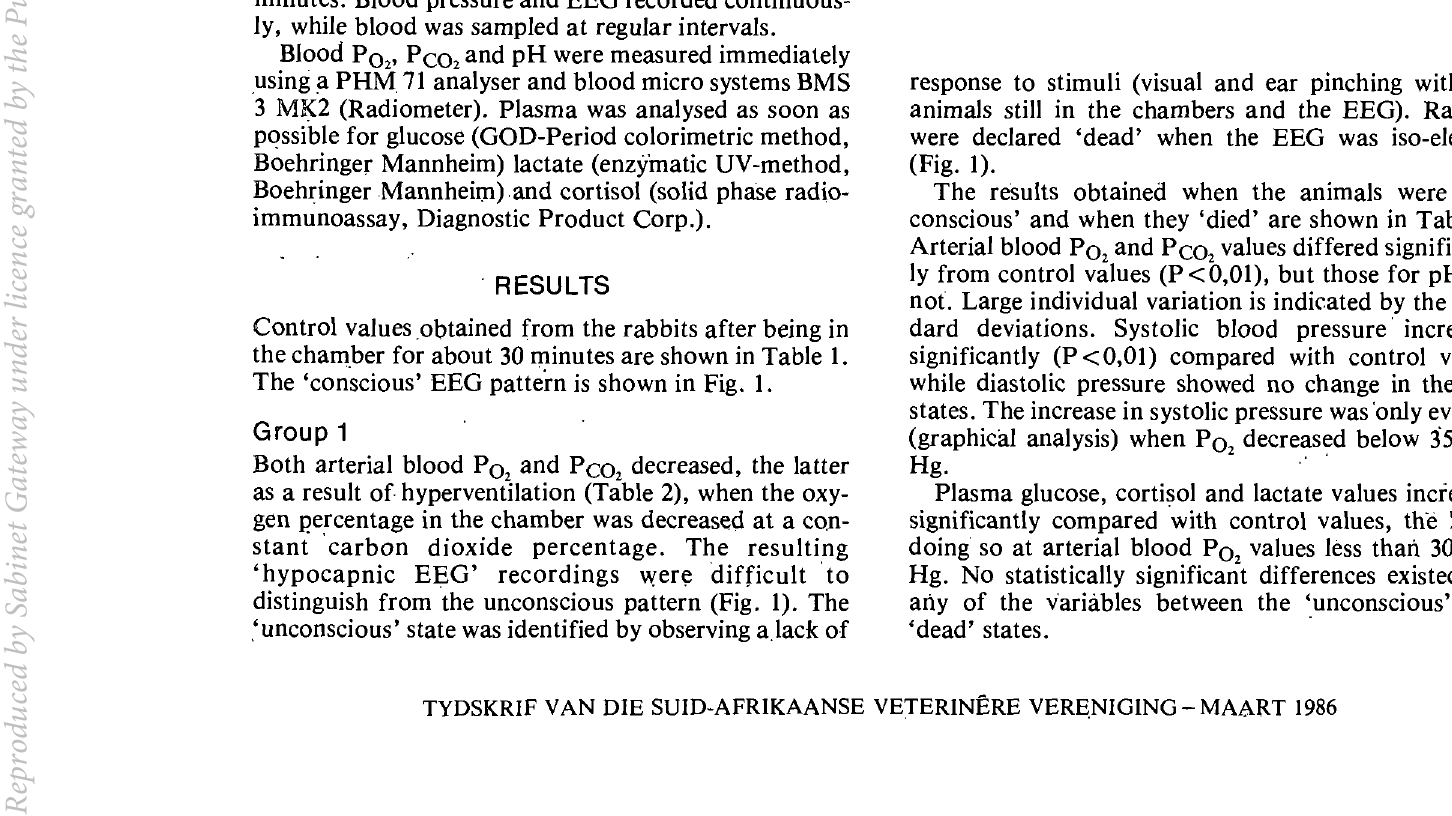
Table 3: Values of variables for Group 2 (normal oxygen, high carbon dioxide) animals when 'unconscious' and 'dead' (Means ±